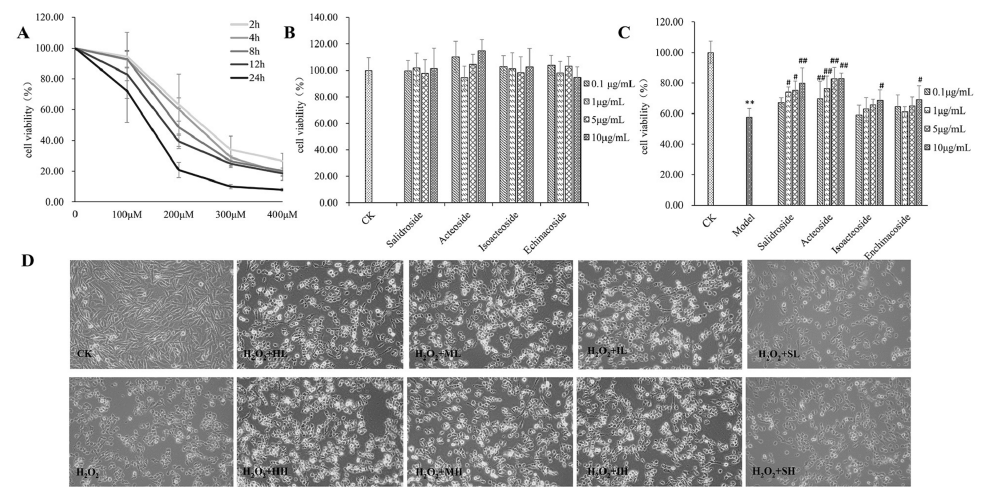
Figure 1. PhGs suppressed H 2 O 2 -induced cytotoxicity in PC12 cells. Cell viability was detected by MTT